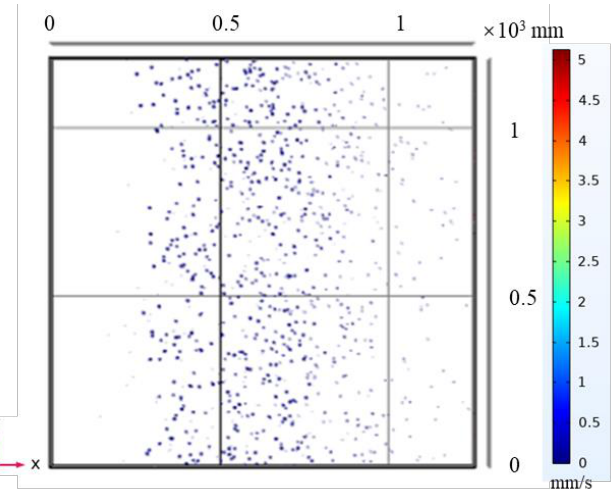
Figure 11. Particles embedded in the adhesive layer in the field model ( z = 100 mm).